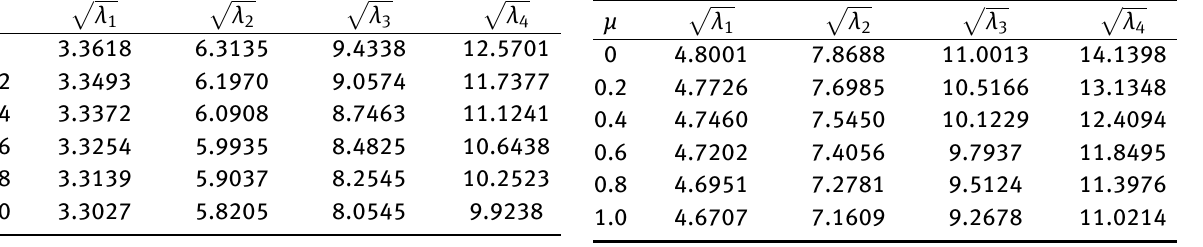
(︁ √ )︁ for CF case for different nonlo- λ